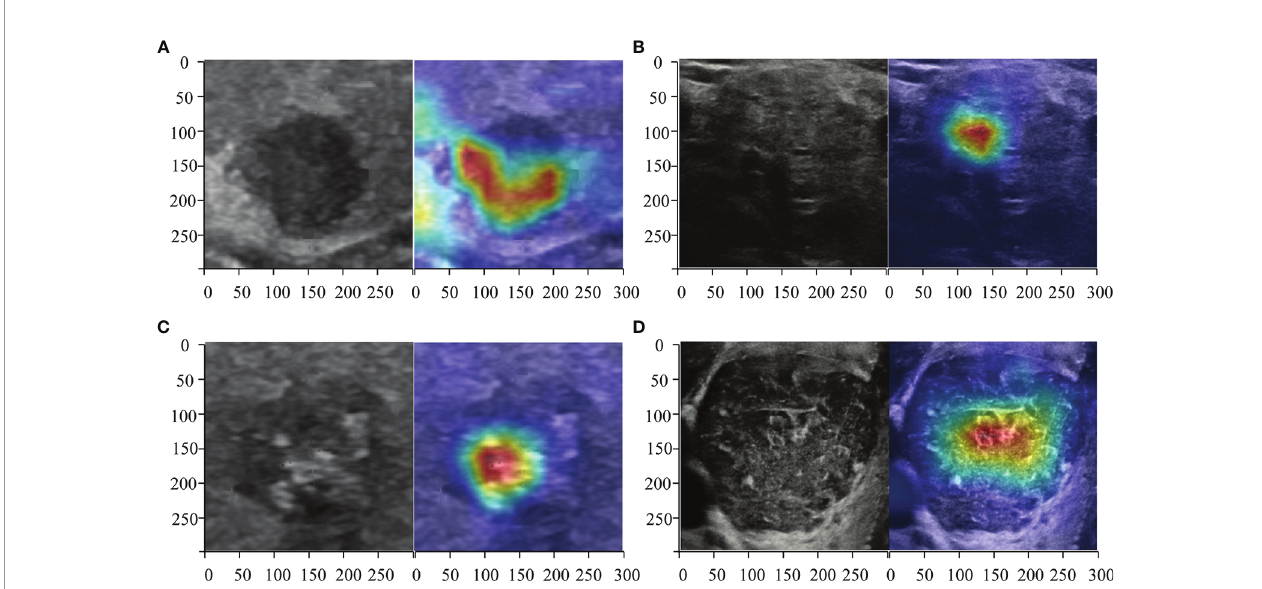
FIGURE 2 | Heatmaps of the region of interest (ROI) of the thyroid nodules using class activation mapping (CAM). The red color showed the prediction regions the CNNs focused which estimated to be determined as the thyroid cancer. Three radiologists and DL correctly predicted a malignant (A) thyroid nodule diagnosed as micro papillary carcinoma TR4 and a benign (B) one diagnosed as non-toxic nodular goiter of TR4. ResNet50, Desnet121, and the radiologists deemed a malignant nodule (C) diagnosed as papillary carcinoma of TR5 as malignance but a DL algorithm named Inception-ResNet version 2 judged it as benign. All CNNs correctly predicted a benign (D) thyroid nodule diagnosed as Hashimoto ’ s thyroiditis of TR5 but the radiologists all predicted